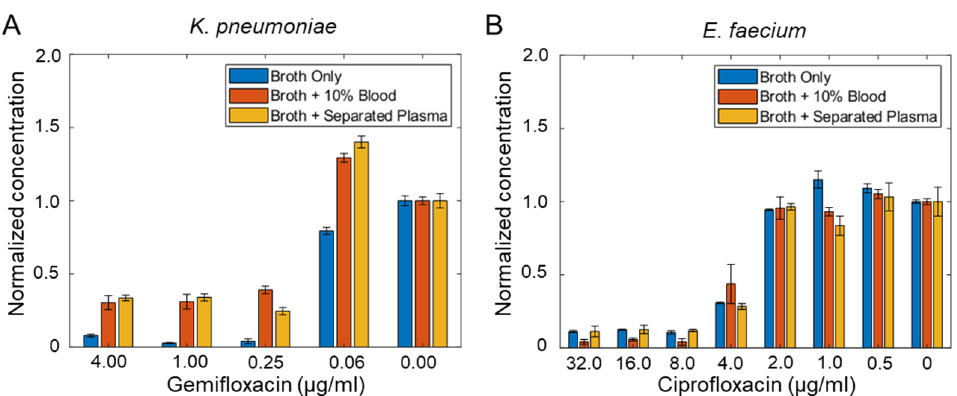
Figure 4. Effect of dextran on minimum inhibitory concentration. ( A , B ) Phenotypic growth of ( A ) K. pneumoniae and ( B ) E. faecium in buffer, 10% blood, and dextran-separated plasma. The experiment was performed using 5 mL blood tubes. The samples were plated on agar plates for approximately 24 h for colony counting. The minimum inhibitory concentration values were not affected by the dextran sedimentation protocol. Data represent mean ± s.e.m. ( n = 3).